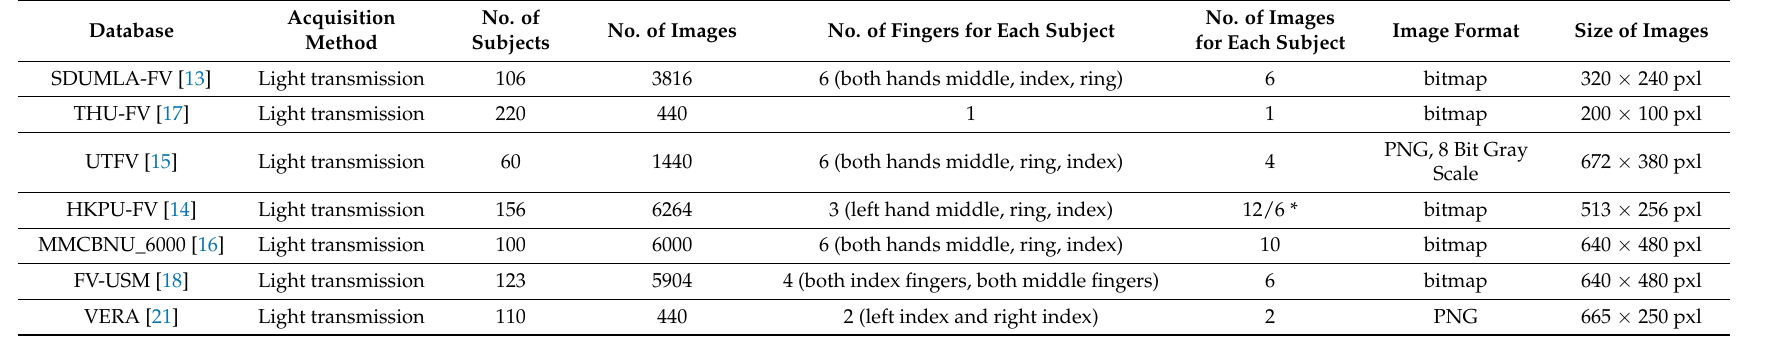
Table 2. Detail of finger vein image